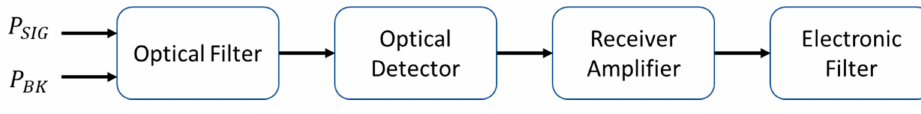
Figure 22. Receiver system for lasers. Adapted from [28].